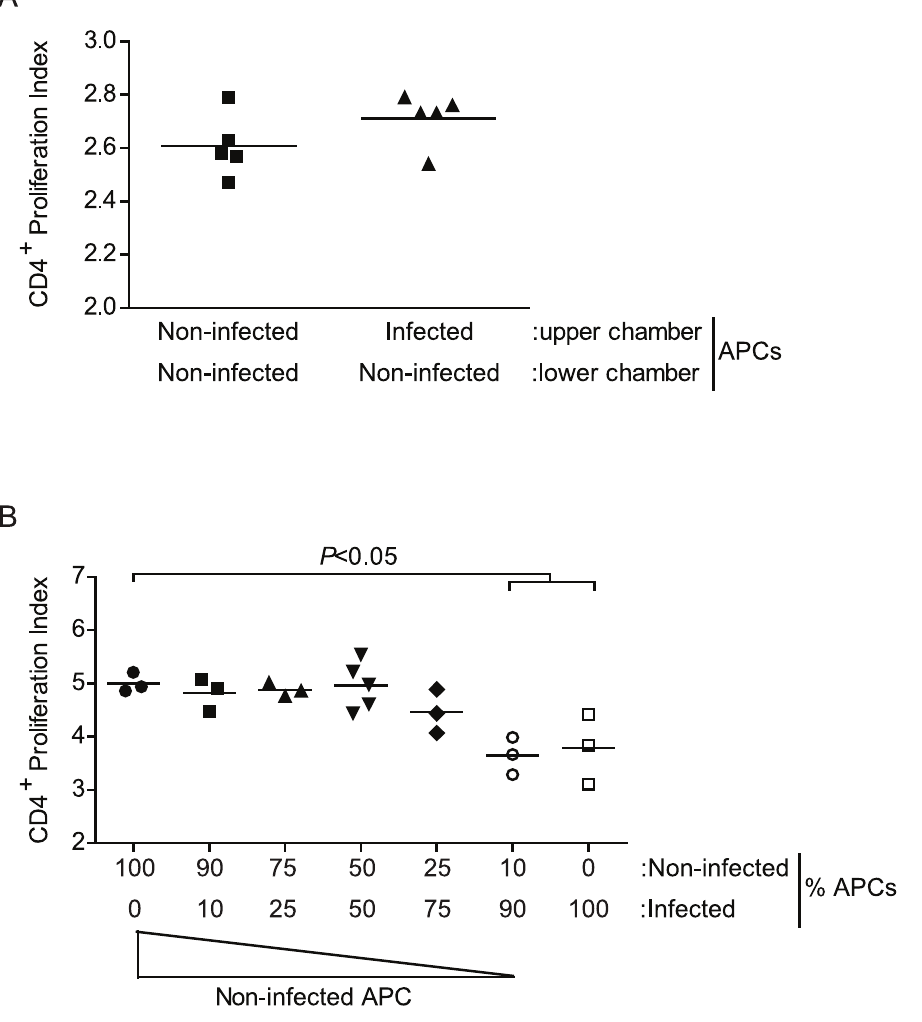
Figure 7. T cellsuppressioninducedbypre-patentschistosomeinfectioniscellcontact-dependent. A, Transwell experiment was performed where the lower chamber contained splenocytes isolated from non-infected RAG-1 2 / 2 mice co-cultured with CFSE-stained CD4 + T cells isolated from non-infected OT-II/RAG-1 2 / 2 mice. Upper chamber contained splenocytes isolated from 4 week S. mansoni -infected or non-infected RAG-1 2 / 2 mice. Cells were co-cultured for 72 hours in the presence of OVA peptide and CD4 + T cell proliferation was analyzed by flow cytometry. Horizontal bars represent mean of 5 independent mice. B, Competition assay was performed where varying proportions of splenocytes isolated from 4 week S. mansoni -infected or non-infected RAG-1 2 / 2 mice were co-cultured with CFSE stained CD4 + T cells isolated from non-infected OT-II/RAG-1 2 / 2 mice. CD4 + T cell proliferation was analyzed by flow cytometry. Horizontal bars represent mean of 5 independent mice. APCs, antigen presenting cell.